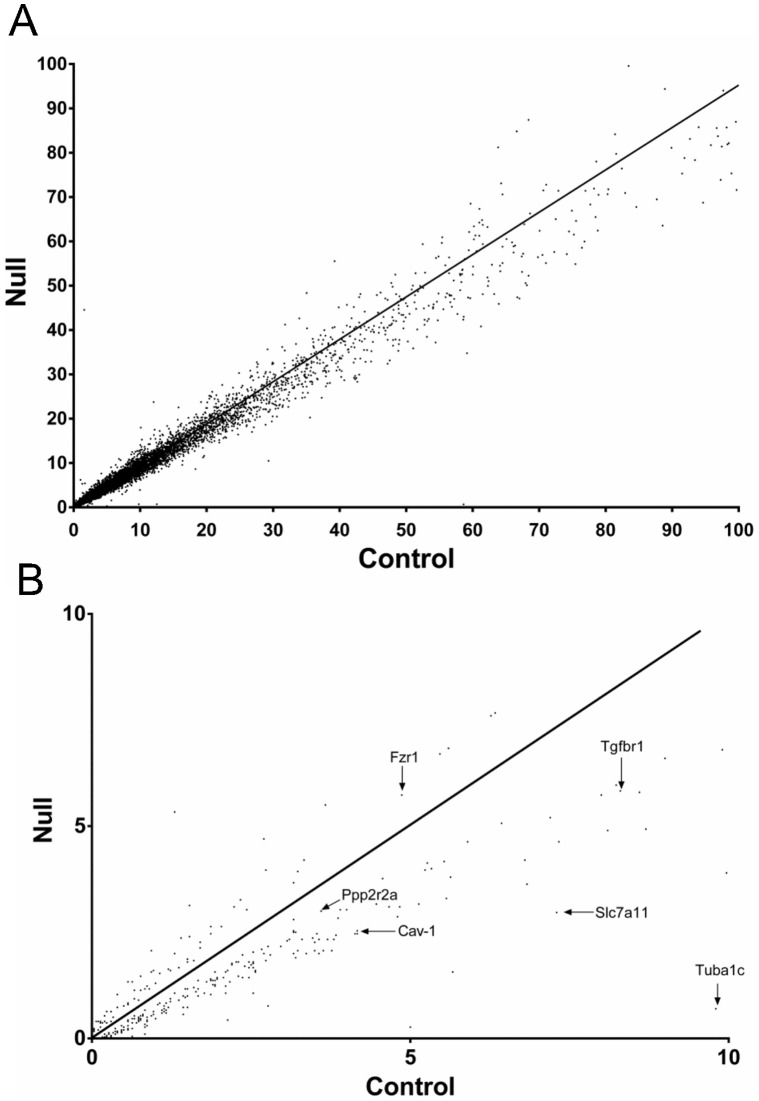
Scatter plot of expression level measured by RPKM: control vs. Hltf knockout.Panel A, each point is the mean of three replicate RPKM values for an individual gene in control brain plotted against values of the corresponding gene in Hltf null brain. The black line indicates the linear regression. R2 = 0.9866, correlation coefficient. Panel B, genes with statistically significant expression (each dot is the mean of three replicate RPKM values, differential expression >1.1 fold, and P<0.05 in control vs null brain samples. Genes with dramatic outlier expression such as Tuba1c (14-fold) are indicated.